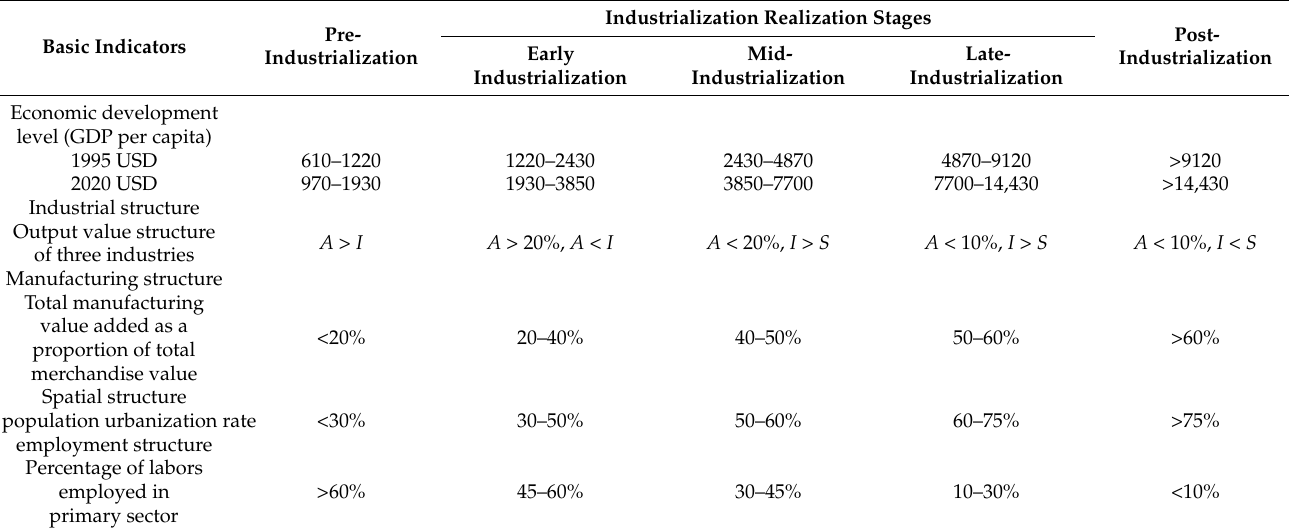
Table 3. Marker values for different industrialization stages.